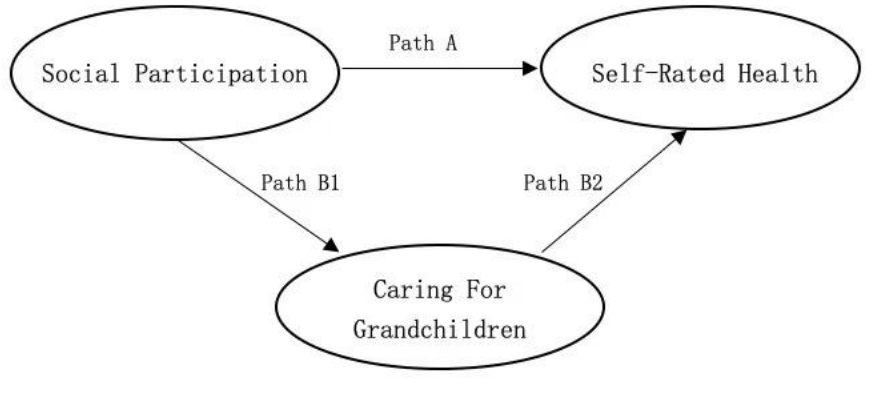
Figure 1. Conceptual framework.